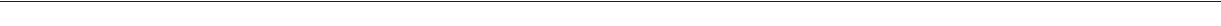
Fig. 7 Flotillin expression is required for conjugate formation and T cell signaling. a Representative fl ow cytometry dot plots of wildtype and Flotillin1/2 KO Jurkat T cells conjugated to SEE pulsed Raji B cells and stained with cell viability dye and CFDA, respectively. b Percentage of stable T – B cell conjugates determined as violet dye and CFDA double positives, relative to total cell population. c Flow cytometry quanti fi cation of WT and fl otillin1/2 KO Jurkat T cells activated with soluble CD3 ε and CD28 and fi xed prior or 5, 10, and 20 min after activation. Cells were stained with antibodies against phosphorylated (left) TCR ζ -pY142, (middle) Zap70-pY493, and (right) ERK-pY202/204. d Representative immuno fl uorescence microscopy images of WT and fl otillin1/2 KO Jurkat T cells stained with antibodies against nuclear factor of activated T-cells (NFAT) and e the integrated NFAT fl uorescence intensity over the Hoechst-stained nucleus in WT and fl otillin1/2 KO Jurkat T cells activated or not with anti-CD3 ε and CD28 antibodies. f Representative immuno fl uorescence microscopy images of WT and fl otillin1/2 KO Jurkat T cells stained with antibodies against T-cell-speci fi c adaptor protein (TSAd) and g the integrated TSAd fl uorescence intensity over the Hoechst-stained nucleus in WT and fl otillin1/2 KO Jurkat T cells activated or not with anti-CD3 ε and CD28 antibodies. Scale bars, 5 µ m. Data obtained from three or more independent experiments. Error bars indicate mean (±SEM). * p < 0.01; ** p <